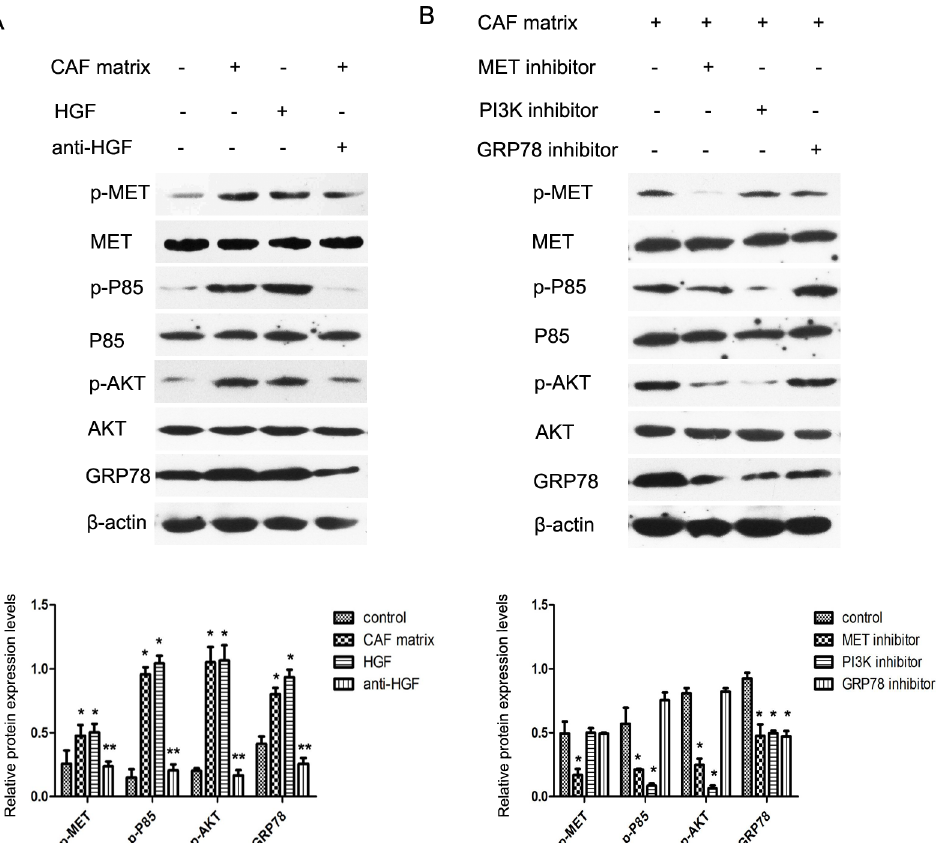
Fig 3. Western blot analysis of the c-Met/PI3K/AKT activation and GRP78 expression in A549 cells. A549 cells were cultured in the condition as described above and the relative levels of phosphorylated Met, PI3Kp85, AKT and GRP78 expression in the different groups of cells were characterized by Western blot assays and quantified. Data are representative images and expressed as the means ± SD of each protein in individual groups of cells from three separate experiments. * P < 0.05; ** P < 0.01 vs. the controls.